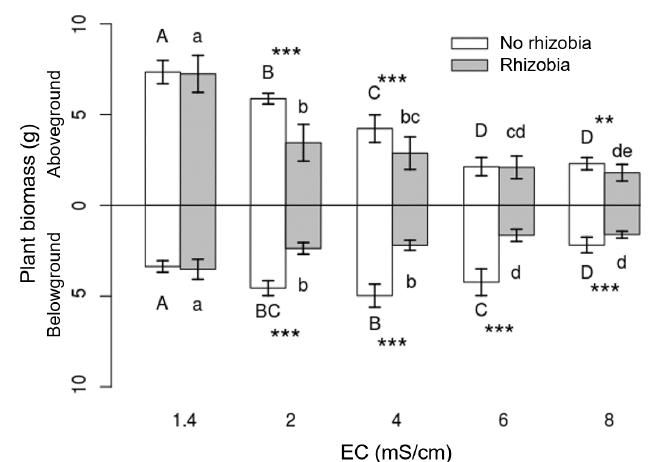
Fig. 3: Above- and belowground plant biomass. Plants with and without rhizobia were grown in soils with different electrical conductivity (EC) and plant above and below biomass (dry weight) was deter- mined after 8 weeks of cultivation. Bars are means (±SD), stars represent statistical difference based on t-tests within EC treatment groups (significance: ** p<0.01, *** p<0.001). Lower (rhizobia) and upper case letters (fertilizer, no rhizobia) show significant differ- ences among experimental plants according to post-hoc analysis (Tukey’s HSD, p<0.01) after one-way